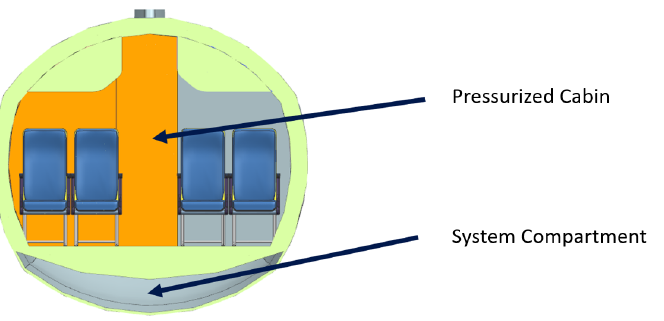
Figure 12. Cross-sectional view of the cabin section, showcasing the pressurized cabin and the unpressurized system compartment.